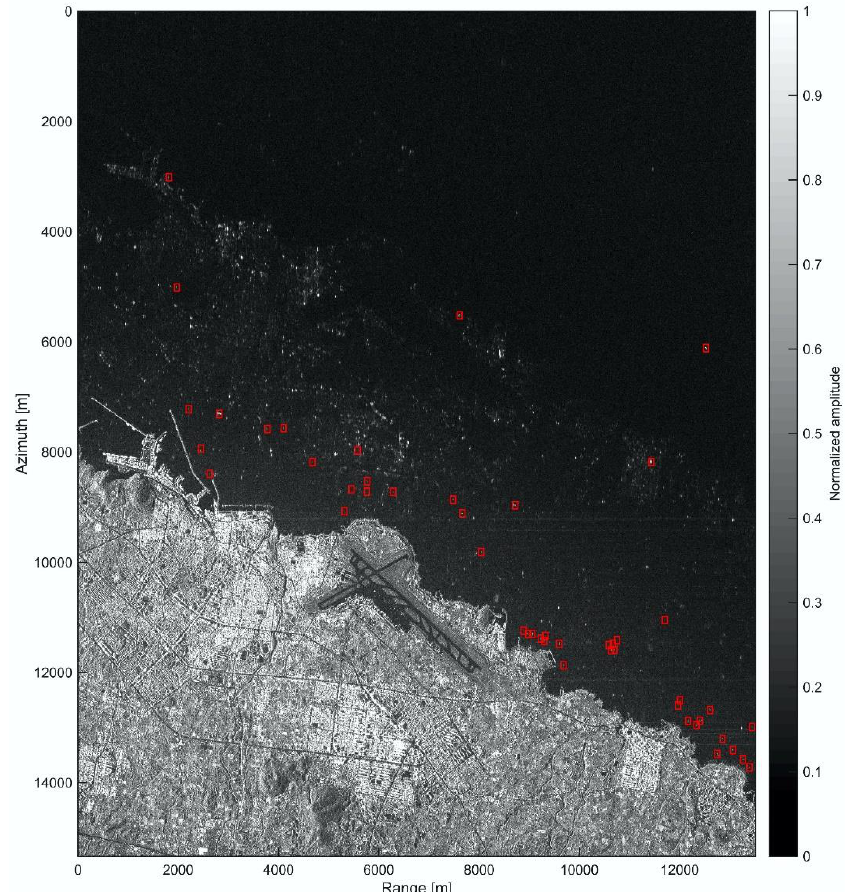
Figure 2. Test image of the northern coast of Jeju Island. The SAR data were acquired by the TerraSAR-X descending model with an incidence angle of 53.8 degrees at the scene centre. Red squares indicate the locations of vessel traced by the AIS system. True marine targets, such as vessels or bottom rocks, exposed above the water surface are severely mixed with ghosts (or azimuth ambiguities) in the coastal water, and consequently, it is very difficult to detect true coastal targets.